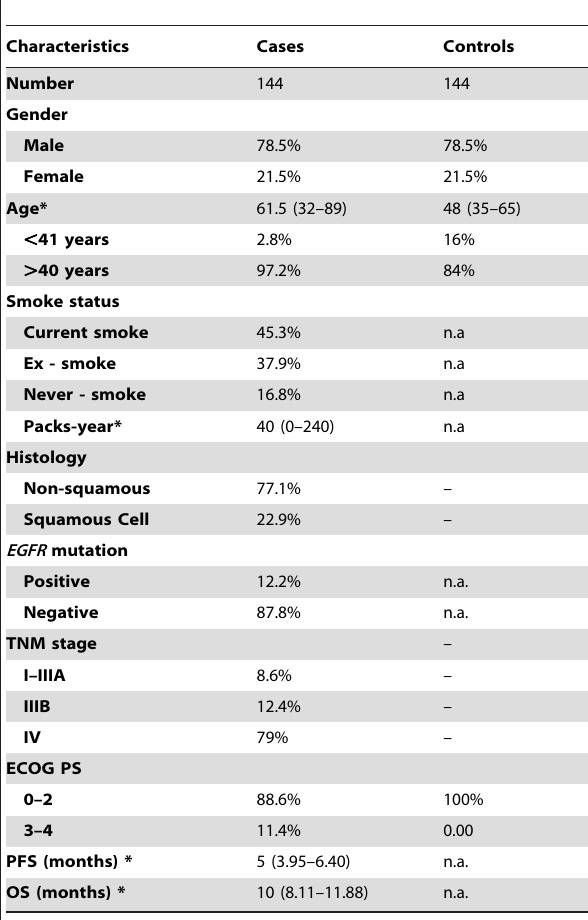
Table 2. Summary of clinical-pathological features of subjects and